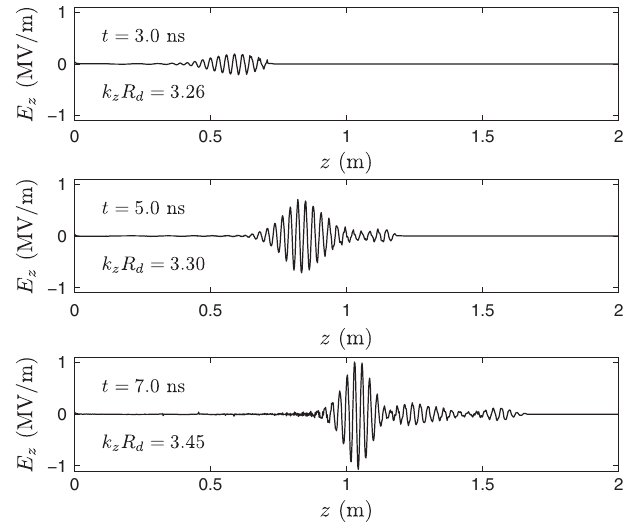
FIG. 15. Spatial pulse evolution for a 50 A beam with (cid:1) ¼ 1 showing shift in resonant wave number from k linear regime to k